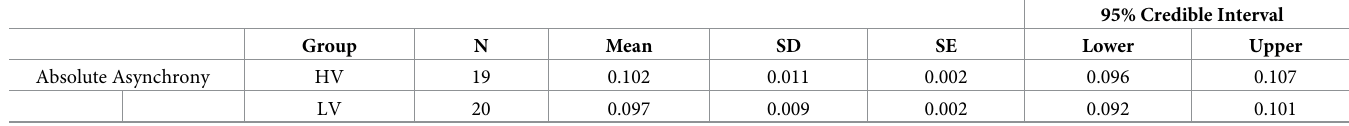
Table 4. Descriptive statistics. Descriptives of the comparison of mean absolute asynchrony in HV and LV groups by means of a Bayesian independent